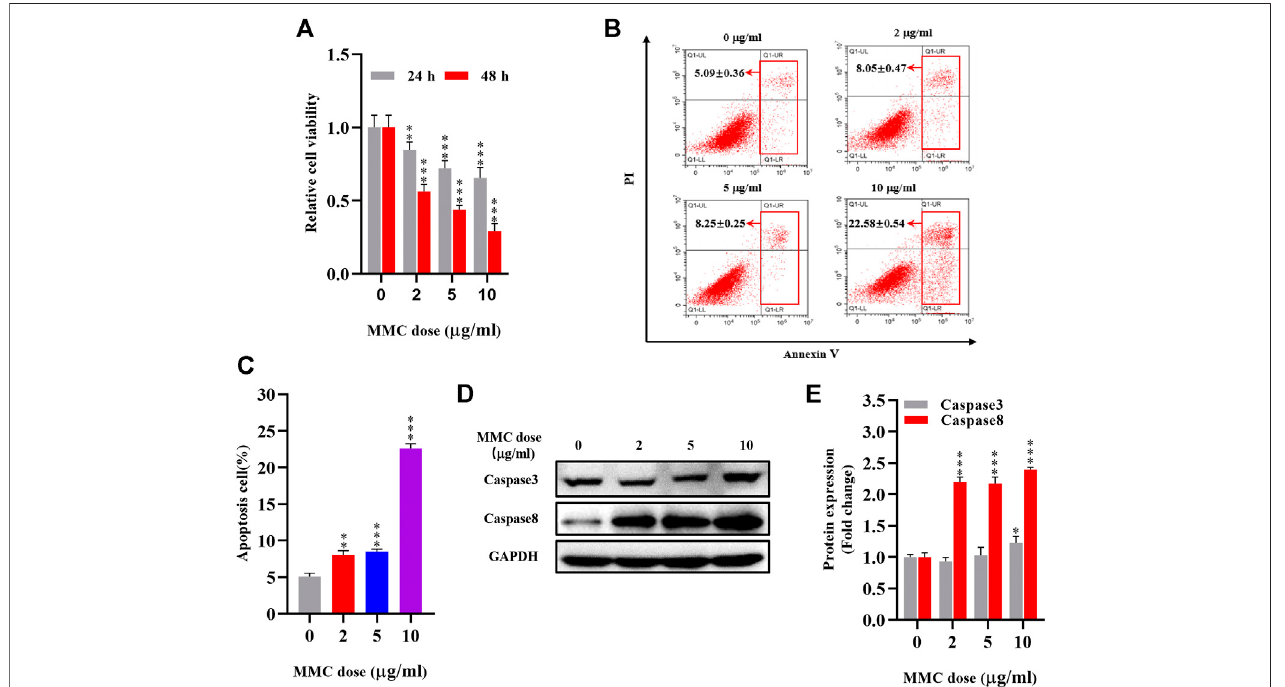
FIGURE 1 | MMC inhibited HEFs proliferation and induced cell apoptosis. HEFs cells were treated with MMC at 2, 5, and 10 μ g/ml for 24 or 48 h (A) Cell viability was assessed by CCK-8 assay with HEFS treated with or without MMC for 24 or 48 h (B) Apoptosis was assessed by annexin V-FITC/PI staining followed by fl ow cytometrywithHEFStreatedwithorwithoutMMCfor24 h (C) Apoptosispositivecellswerecountedfromthreeindependentexperiments. (D) Westernblottingwasused to determine the expression levels of Caspase3 and Caspase8 with HEFS treated with or without MMC for 24 h (E) Relative protein expression levels by image J statistics from three independent experiments. Data are shown as the means ± SEM from three independent experiments. ** P < 0.01,*** P < 0.001 vs.